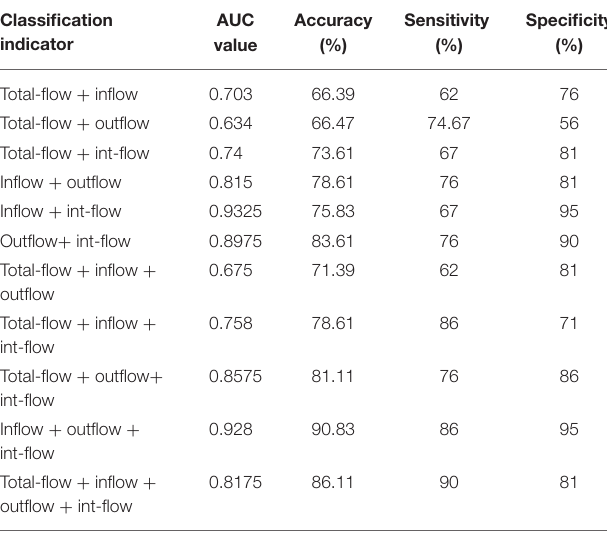
TABLE 3 | Classification performances using combinations of GCD metrics.